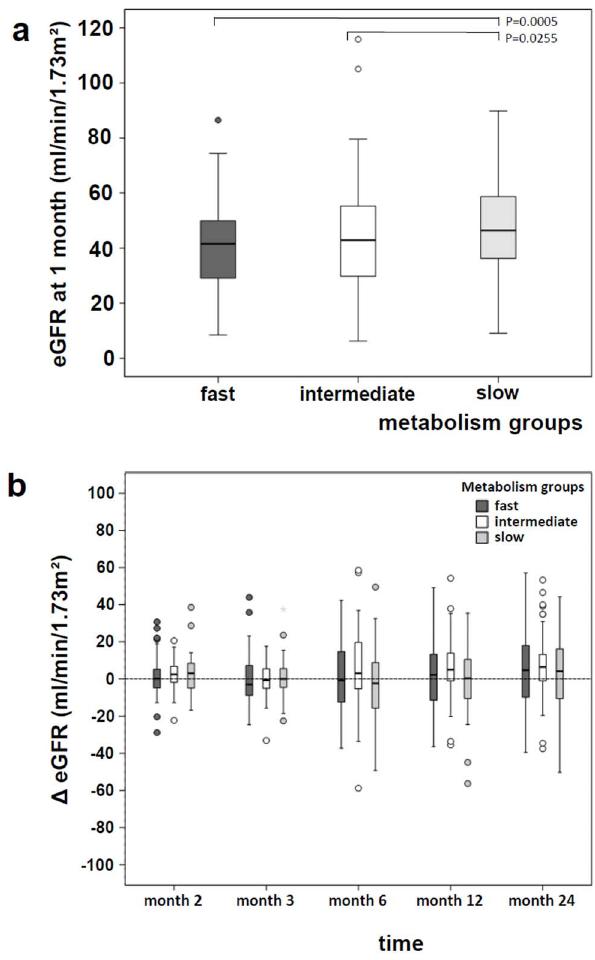
Figure 2. eGFR value comparison between the three metabo- lism groups ( a). Fast and intermediate Tac metabolizers showed statistically noticeable lower eGFR values compared to slow metabo- lizers one month after RTx. P-values refer to the linear mixed model. Renal function in a 24 months follow-up (b). The differences between the follow-up eGFR values (month 2, 3, 6, 12, 24) and the eGFR value and the eGFR value at month 1 are shown for every metabolism group.